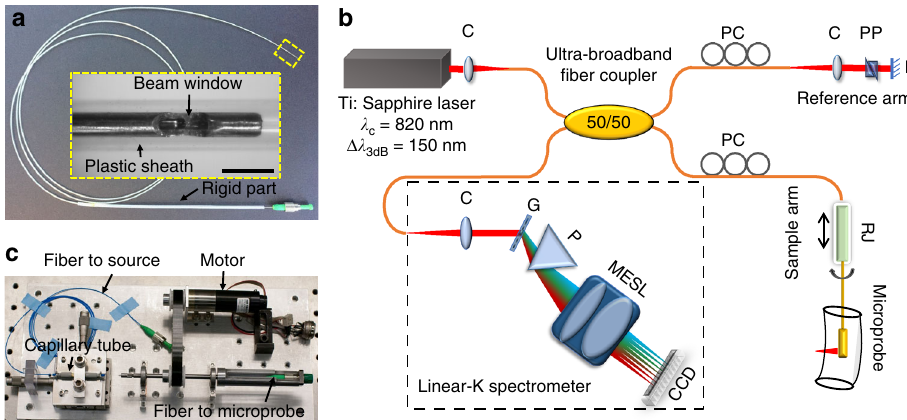
Fig. 3 Experimental setup and microprobe prototype. a Photograph of the super-achromatic microprobe of 2 m in length encased within a transparent plastic sheath of a 1 mm outer diameter (OD), inset: magni fi ed view of the microprobe distal end boxed with yellow dashed lines. Scale bar is 1 mm. b Schematic of the spectral-domain endoscopic optical coherence tomography (OCT) imaging system. c Photograph of the home-made rotary joint consisting of a glass capillary tube. C achromatic collimator, CCD line scan charge-coupled device, G grating, M mirror, MESL multi-element scan lens, P linear-K mapping prism, PC polarization controller, PP prism pair, RJ fi ber-optic rotary joint